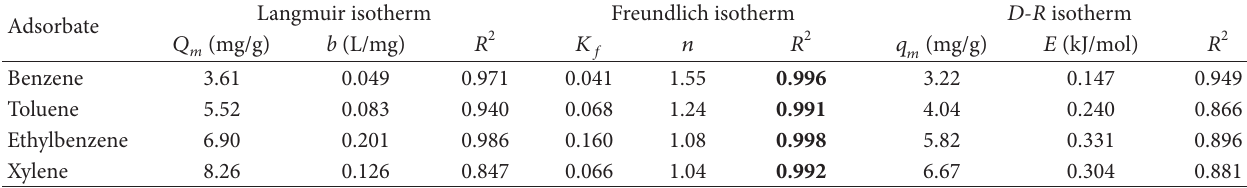
T 4: Parameters for Langmuir, Freundlich, and